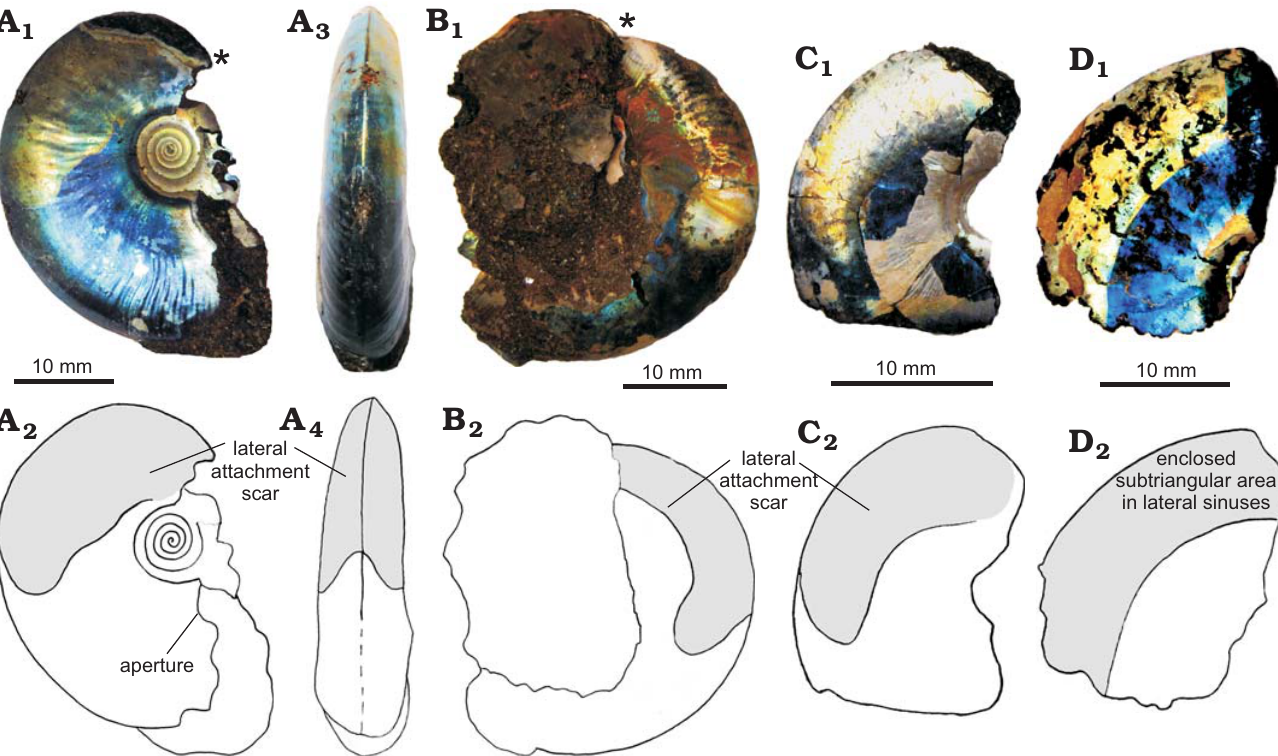
Fig. 7. Lateral attachment scars on Garniericeras catenulatum (Fischer, 1830) shells from Late Volgian ( Craspedites subditus Zone), Yaroslavl region, Cheremukha locality (A, B), and Moscow region, Kuntsevo locality (C, D). A . MSU 113/45, shell with a fully preserved body chamber and clearly visible scars on both sides; in lateral (A the shape of scars on Kachpurites cheremkhensis shells. The aperture is partially preserved. B . MSU 113/44, scar on the shell. C . MSU 113/22, a part of the body chamber with a light-colored scar. D . MSU 113/13, fragment of the phragmocone with a light-colored trace of a scar. Asterisks mark the base of the body chamber. Photographs (A